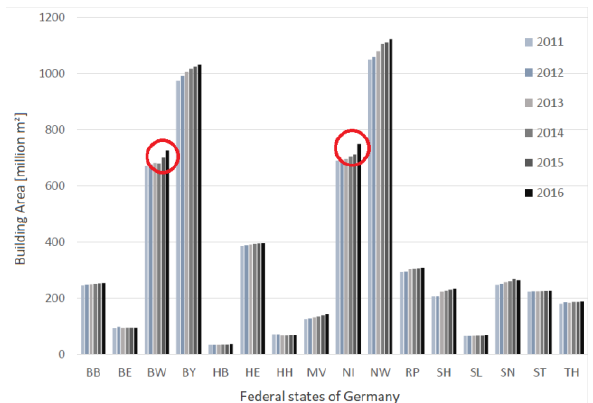
Figure 2. Total area of the building polygons of all 16 German federal states from 2011 to 2016 (unusual increases are marked with a red circle)